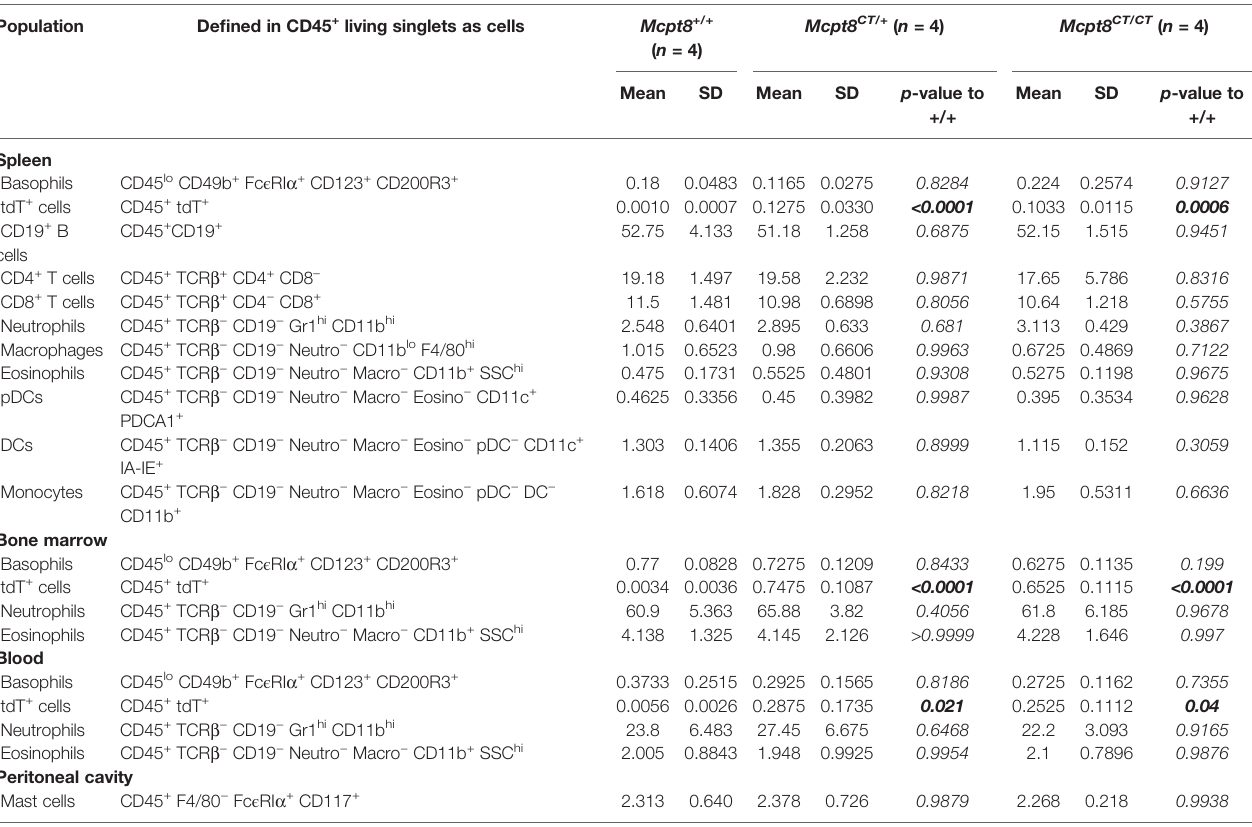
Proportions of immune cell populations among CD45 + cells in the indicated compartments were determined by fl ow cytometry. Cells were de fi ned following the indicated gating strategy; 8- to 15-week-old mice were analyzed. Statistical analysis was done by one-way analysis of variance (ANOVA) followed by Tukey ’ s multiple comparison test. p-values indicated are from comparison to the Mcpt8 +/+ group. SD, standard deviation. Bold/Italic values in Table 1 and 2 are the statistically signi fi cant values